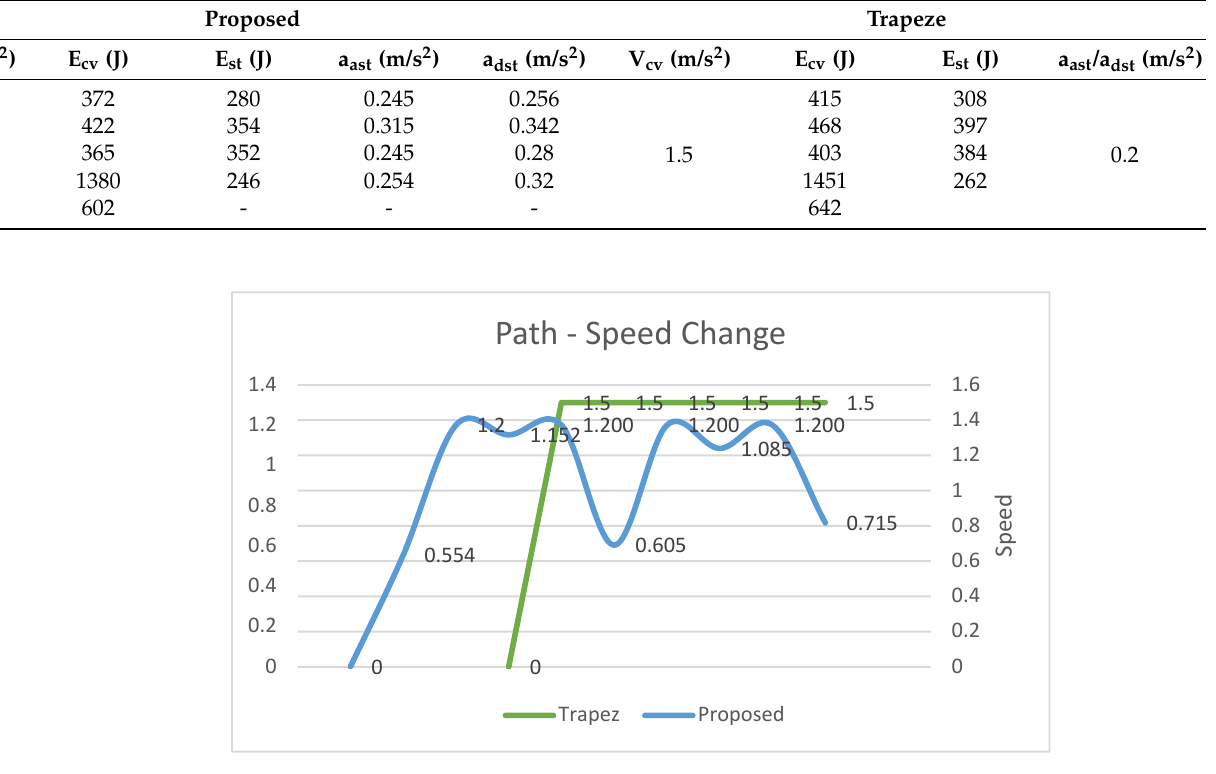
( a ) ( b ) Figure 14. Proposed and Trapeze speed profiles: ( a ) curve energy consumption: Vmax=1.2, ( b ) straight energy consumption: Vmax=1.5. Scenario 2: Energy-Balanced Travel using the Gini Coefficient . The results obtained by the balanced distribution of the remaining energy by the Gini coefficient, according to the change in the estimated amount of energy consumption in dynamic environments, are presented in Table 4. This method appears to achieve a new maximum velocity relative to the remaining energy. (Note that 100 J unexpected energy consumption is added after the first curve path and the first straight path.)